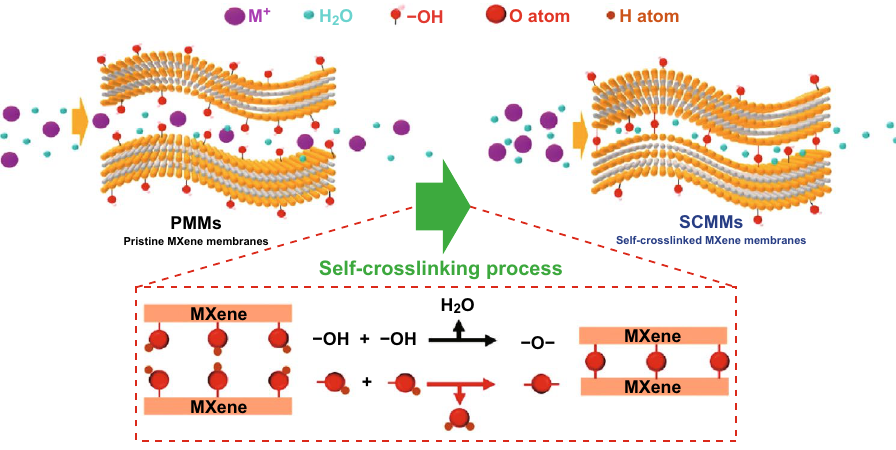
Fig. 8 Self-cross-linking process of the MXene membranes. Reprinted with permission from Ref. [57]. Copyright © (2019) Royal Society of Chemistry